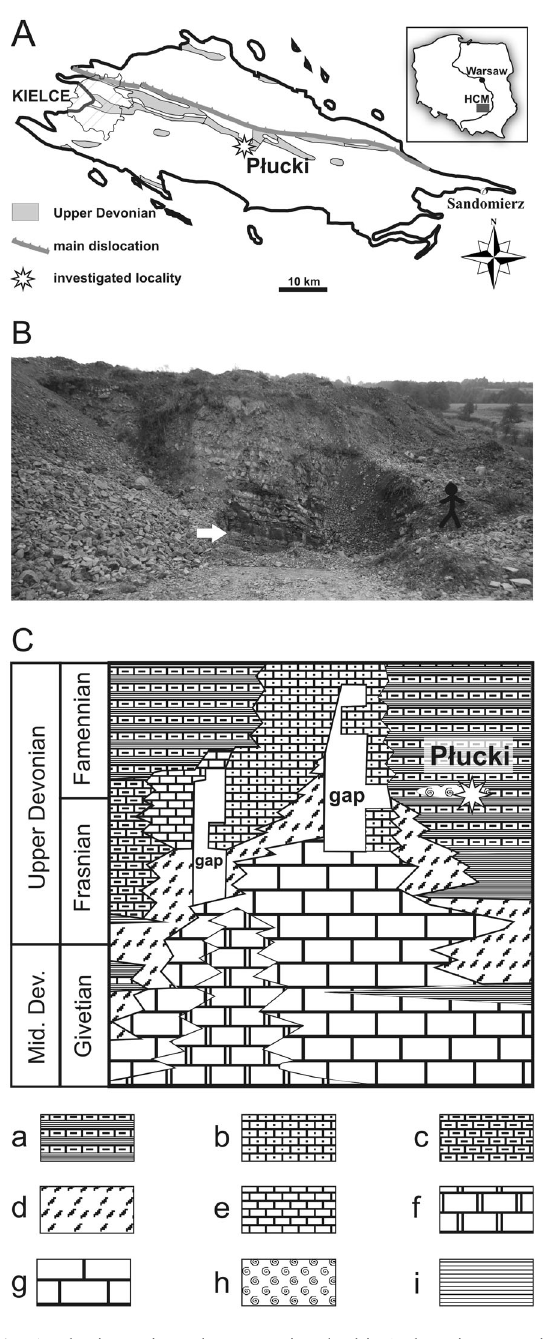
Fig. 1. The investigated outcrop in P ł ucki. A , location map in the Holy Cross Mountains (HCM), Central Poland (modified from Kowalczewski 1971). B , general picture of the outcrop; the place of the fossil-bearing horizon is marked with an arrow. C , diagrammatic cross section through the Holy Cross Mountains from the Givetian to the top of the Upper Devonian (modified after Szulczewski 1995) with the probable position of the investigated localities (a, marly limestones and shales; b, condensed cephalopod and crinoidal limestones; c, marly limestones; d, calcirudites; e, bedded limestones; f, dolomites; g, massive and bedded limestone; h, cephalopod limestones; i, clayey and marly